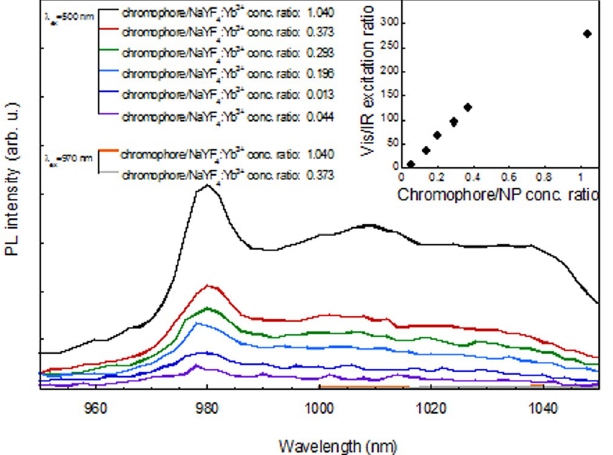
Figure 4. NIR emission spectra of 2-hydroxy-perfluoroanthraquinone-functionalized Yb 3 + -doped (10%) NaYF 4 nanoparticle prepared with different chromophore to nanoparticle suspension concentration ratios (by varying the amount of chromophore for a constant nanoparticle suspension concentration of 0.182 mg/ml). The inset shows the corresponding excitation ratios, derived from the total PL intensity at 1030 nm, for visible (400–700 nm) excitation divided by the intensity for IR excitation (890–1020 nm), see Fig.